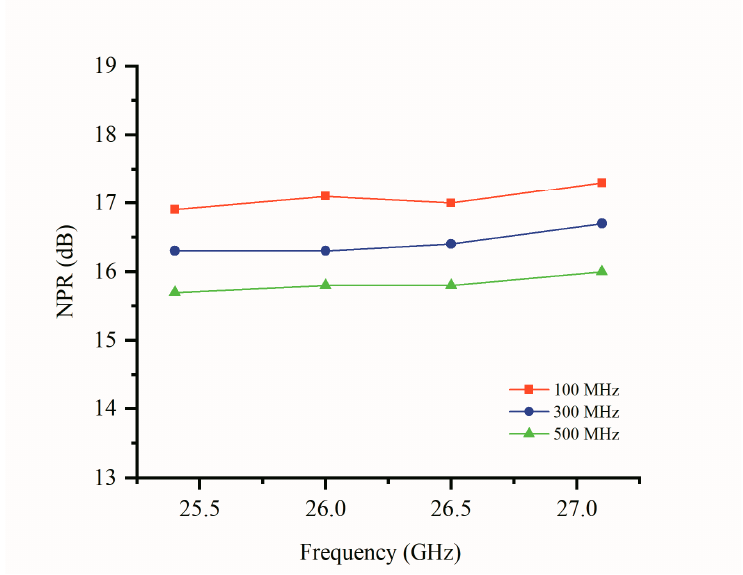
Figure 13. NPR performance of LTWTA with a signal width change when OBO = 3 dB.